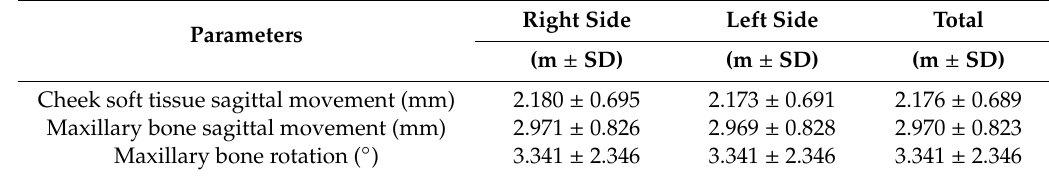
Table 3. Three-dimensional soft tissue and bone movements.